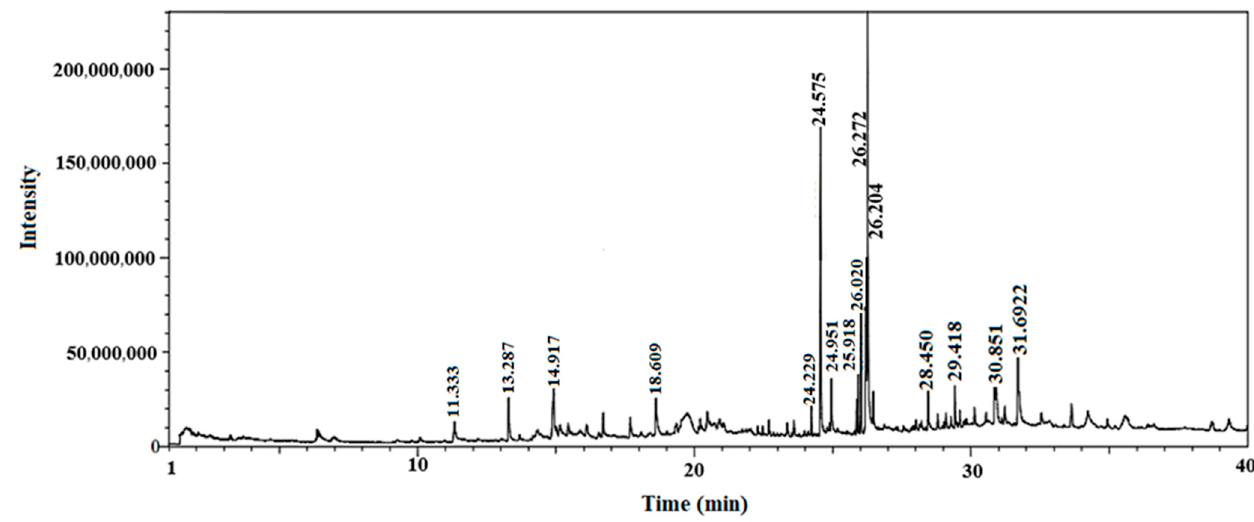
Figure 2. GC–MS chromatograms of Fagonia indica in methanolic extract (80% v / v ).